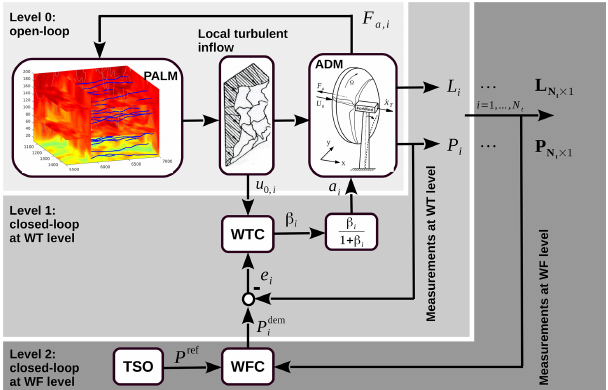
Figure 6. Schematic illustration of the closed-loop wind farm con- trol (WFC) framework developed for APC of waked wind farms. The gray blocks represent the hierarchical structure of the designed APC systems at the wind turbine and the wind farm